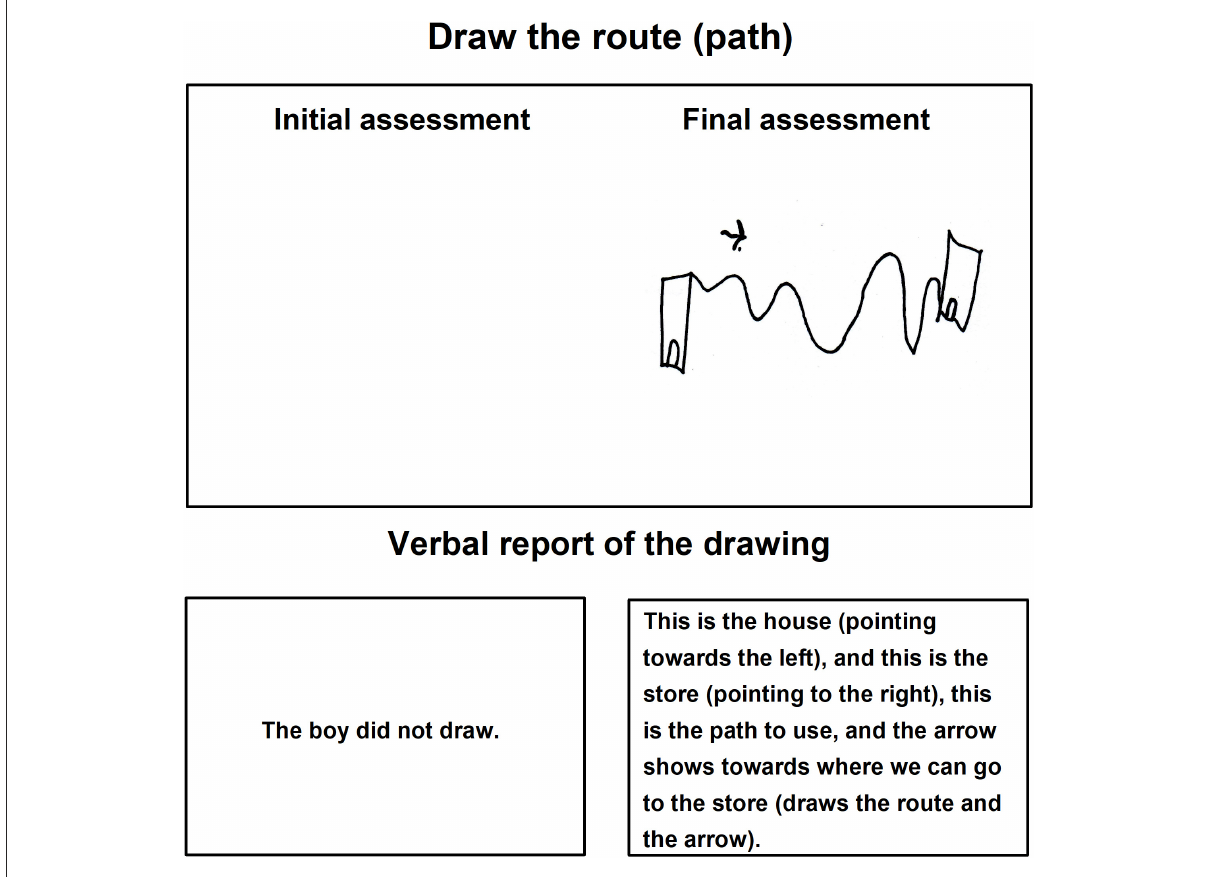
FIGURE6 Child F task drawing the route (path) during the initial and final